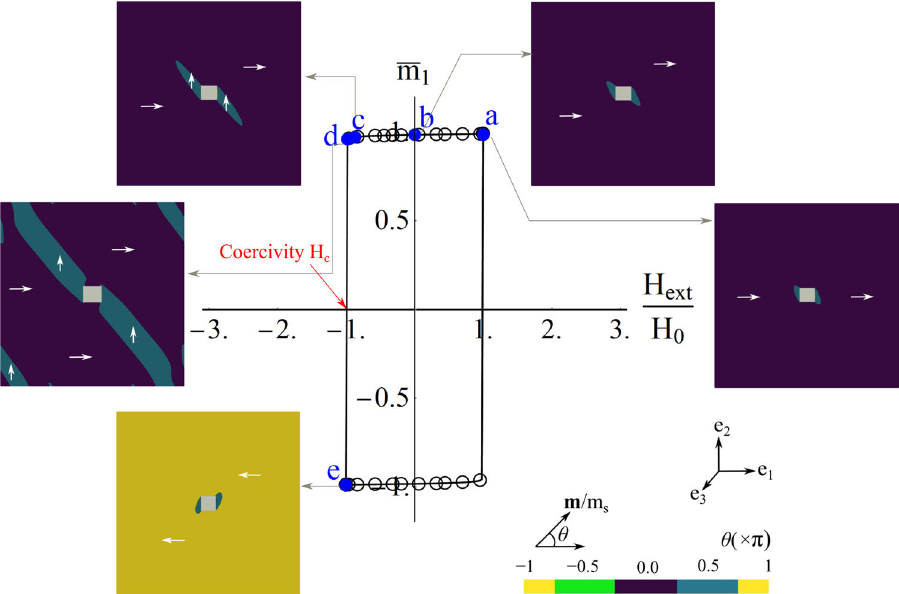
Fig. 4 Growth of a spike-domain microstructure during a typical magnetization reversal. A spike domain forms around a nonmagnetic inclusion in the computation domain. This spike grows gradually on decreasing the external fi eld ( a – c ). At the coercivity value, the spike domain grows abruptly, resulting in magnetization reversal ( d , e ). The hysteresis loop plots the average magnetization in the computation domain m 1 as a function of the applied fi eld H ext .